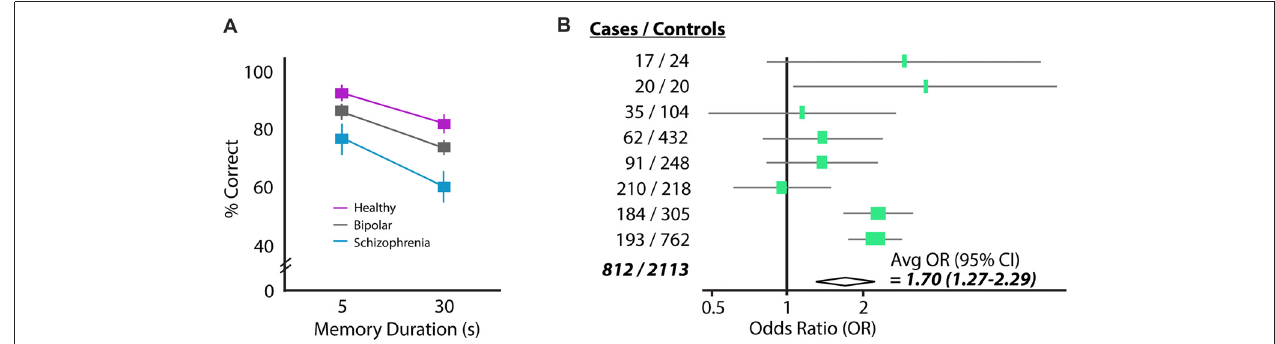
FIGURE 1 | Two common findings in schizophrenia: working memory deficits and elevated homocysteine (HCY). (A) Performance of a schizophrenia, bipolar and control cohort on a delayed saccade task. Subjects must remember the location of a target over a brief delay (5 or 30 s) and move their eyes to the remembered location (reprinted with permission from Park and Holzman, 1992). Schizophrenia patients perform significantly worse than either bipolar or control cohorts. (B) The amino acid HCY is consistently elevated in the blood of schizophrenia patients. Shown are the odds ratios and 95% confidence intervals for having schizophrenia given a 5 µ M increase in plasma total HCY. Eight total case-control studies were analyzed in this meta-analysis, showing the total increase in schizophrenia odds to be 70% given a 5 µ M increase in HCY (reprinted with permission from Muntjewerff et al.,